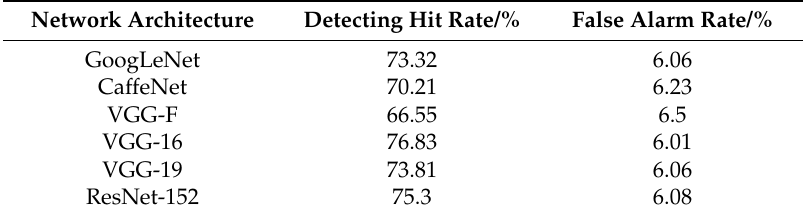
Table 3. Detection performance of the TwinNet framework for six network architectures on 10-class ImageNet.